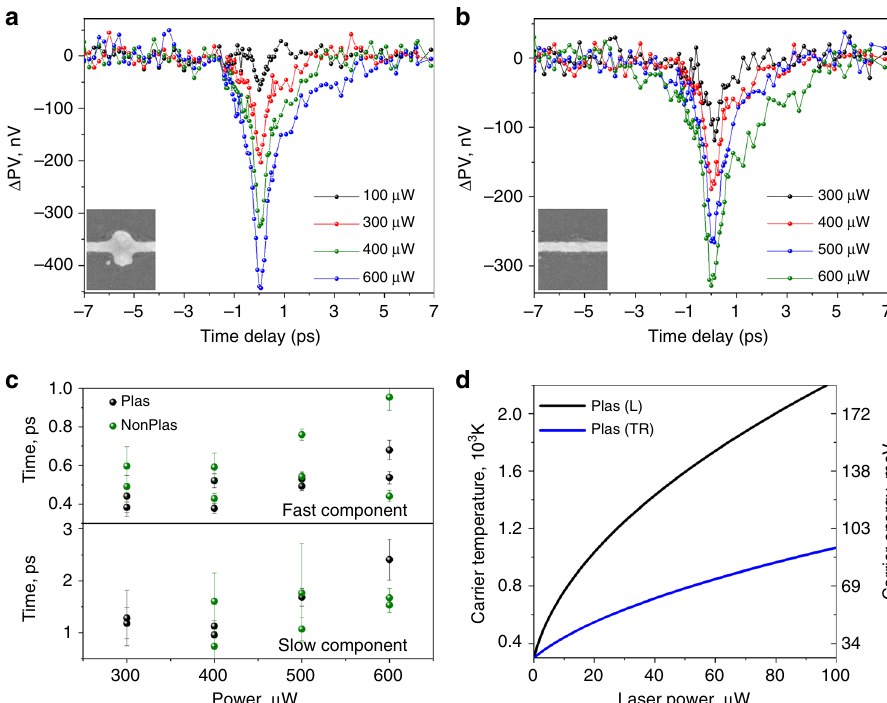
Fig. 5 Plasmon-induced carrier heating. a , b Probe-induced photovoltage at plasmonic and nonplasmonic contacts as a function of pump – probe pulse delay time. Probe at wavelength of 750 nm and 100 µ W power, pump at a wavelength of 650 nm and power as indicated; both beam spots have elliptical shape. c Response time extracted from the bi-exponential decay of the dip in a , b as a function of the pump power. Error bars re fl ect the estimated standard deviation of the fi t coef fi cients. d Power dependence of the carrier temperature and carrier energy in graphene at the plasmonic contact under longitudinal (L) and transverse (TR)